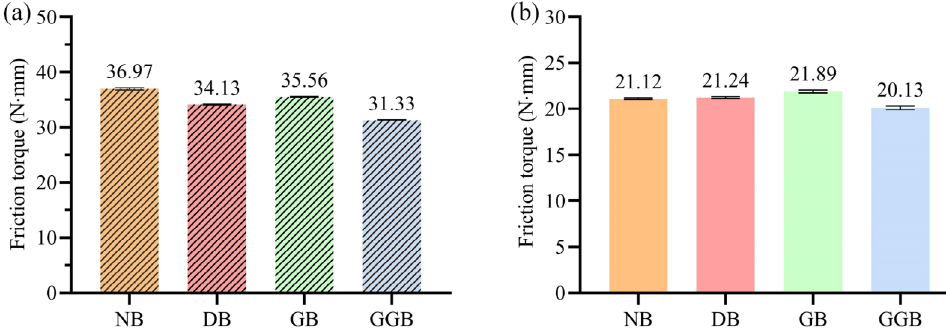
Fig. 14 Friction torque. (a) Bearings after the vibration test and (b) bearings after cleaning and